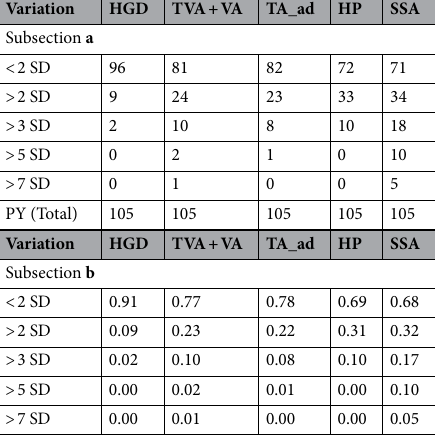
Table 1. (Subsection a ) Comparison of pathologists to self. Number of outlier years for all pathologists with seven years of data. There are 15 pathologists with 7 years of data; thus, there are 105 pathologist x years, (Subsection b ) Comparison to pathologists to self (normalized). Fraction that are outliers for control charts centred on the pathologist’s mean diagnostic rate. The numbers in this table are generated by dividing through by the total number of pathologist x years (105), e.g. 9/105 = 0.09 for HGD 2 SD. SD = standard deviation. HGD high-grade dysplasia, HP hyperplastic polyp, SSA sessile serrated adenoma, TVA + VA tubulovillous adenoma + villous adenoma, TA_ad tubular adenoma + adenoma NOS, PY pathologist-years; 15 pathologists × 7 years = 105 pathologist ×